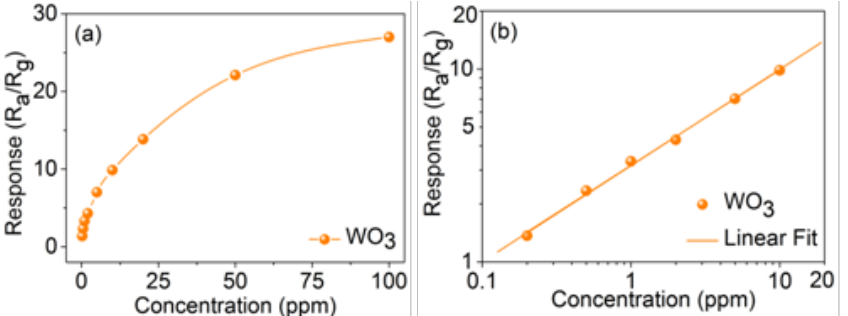
Figure 7. Responses of the 3DIO WO 3 sensor to different acetone concentrations in the normal coordinate system (0.2–100 ppm) ( a ) and log-log coordinate system (0.2–10 ppm) ( b ). Table 1. Comparison of the acetone gas sensing performances of some reported metal oxide sensors and the 3DIO WO 3 sensor in this study.